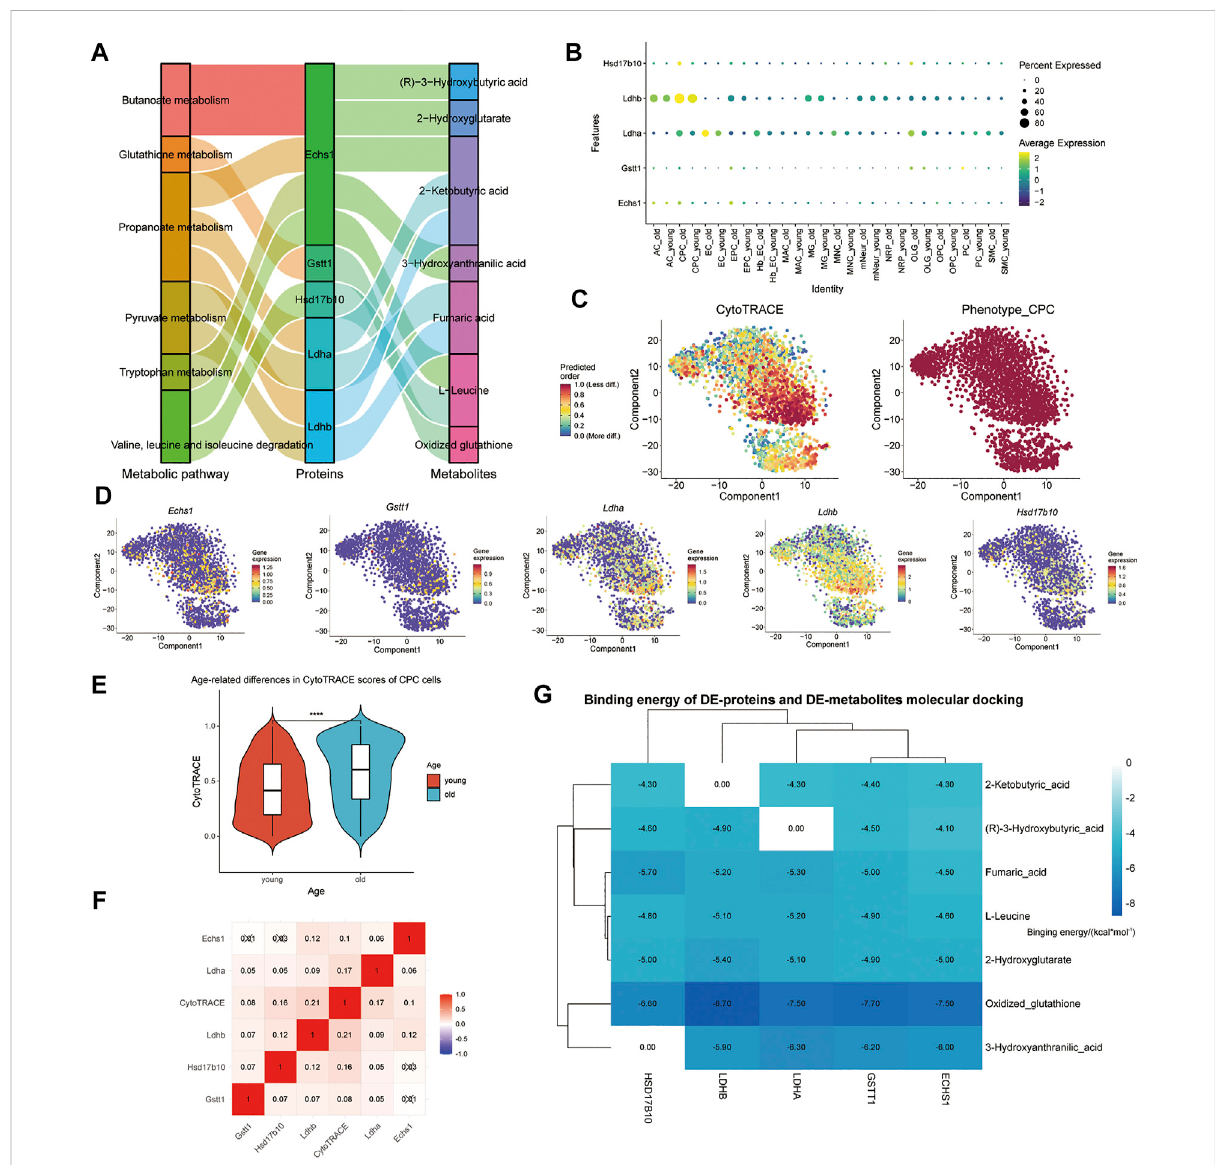
FIGURE 5 Exercise metabolites targeting aging-related metabolic differential proteases in mouse brain tissue CPC may affect the relative differentiation status ofcells. (A) Sankey plots show theseven metabolic pathways regulated bythe fi veCPC age-related differential genes ( Ldhb, Echs1, Hsd17b10, Gstt1, and Ldha )andtheassociatedmetabolitesupregulatedbyexercise. (B) Dotsizeindicatesthepercentageofcellsexpressingeachgene,anddot colorrepresentseachgroup ’ saverageexpressionlevel.TheverticalaxislistsCPC ’ skeymetabolicenzymegenes,respectively. (C) CytoTRACEis used to show the relative differentiation status of CPC. (D) Expression of fi ve CPC age-related differential genes ( Ldhb, Echs1, Hsd17b10, Gstt1, and Ldha ); (E) Cells of young and old CPC cells are shown in a violin plot according to their CytoTRACE scores; (F) Five genes with CPC age-related associations ( Ldhb, Echs1, Hsd17b10, Gstt1 and Ldha ) are shown in the heatmap; (G) Heat map showing the binding free energy of DE-proteins and motility-associated DE-metabolites after molecular